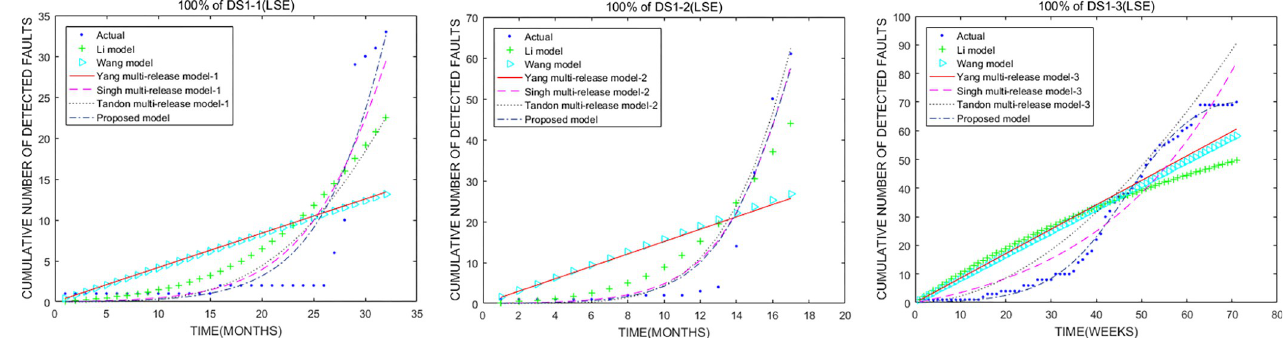
Fig 1. Comparison of the cumulative number of faults estimated by the models using Apache Storm (DS1). (a), (b), and (c) represent the cumulative number comparison of faults estimated by models using 100% of fault data (STORM 1.0.1, STORM 1.0.2, and STORM 1.0.3), respectively.